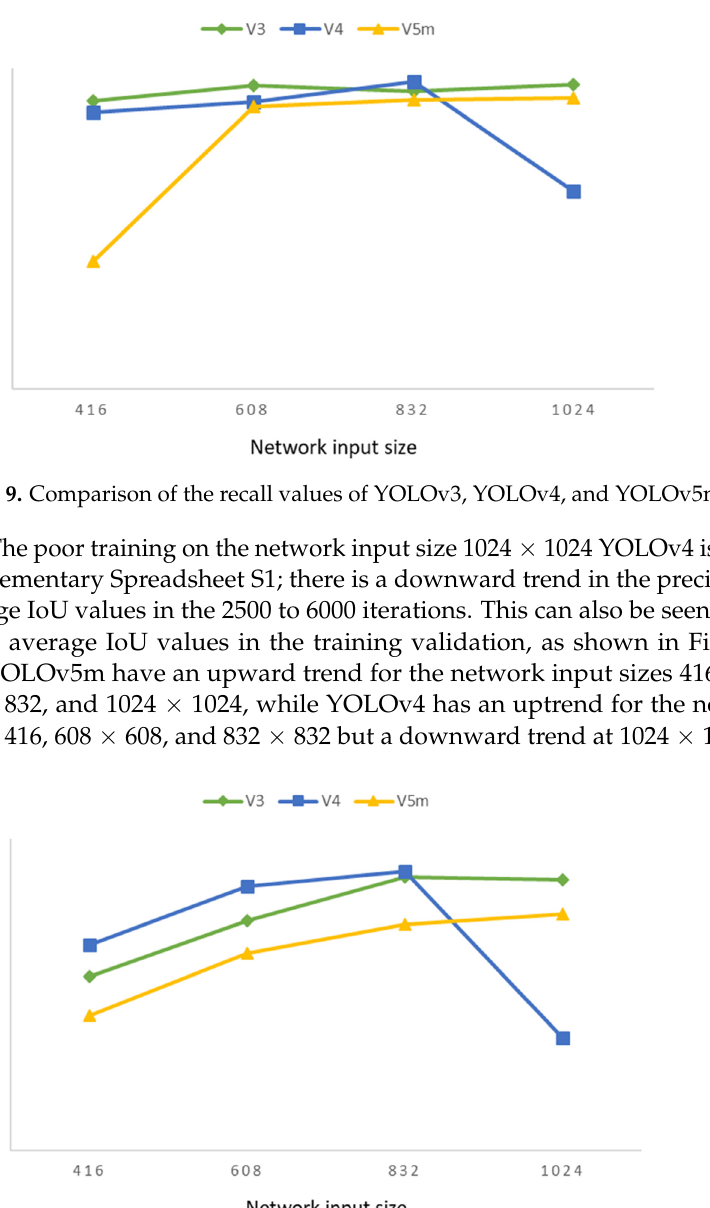
Figure 8. Comparison of the precision values of YOLOv3, YOLOv4, and YOLOv5m.